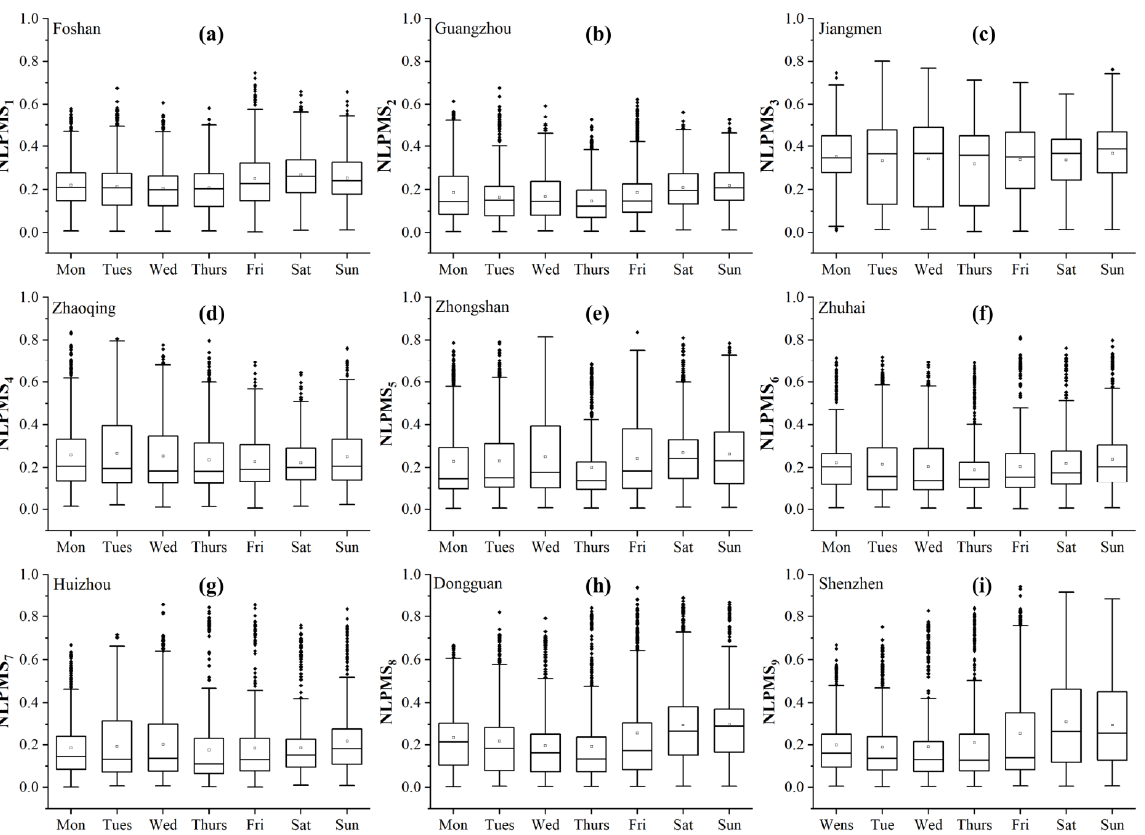
Figure 4. The spatial heterogeneity of intercity mobility structure in the GBA. ( a ), ( b ), ( c ), ( d ), ( e ), ( f ), ( g ), ( h ) and ( i ) show differernt characteristics in the stability of the intercity mobility structures across one week in Foshan, Guangzhou, Jiangmen, Zhaoqing, Zhongshan, Zhuhai, Huizhou, Dongguan and Shenzhen, respectively.